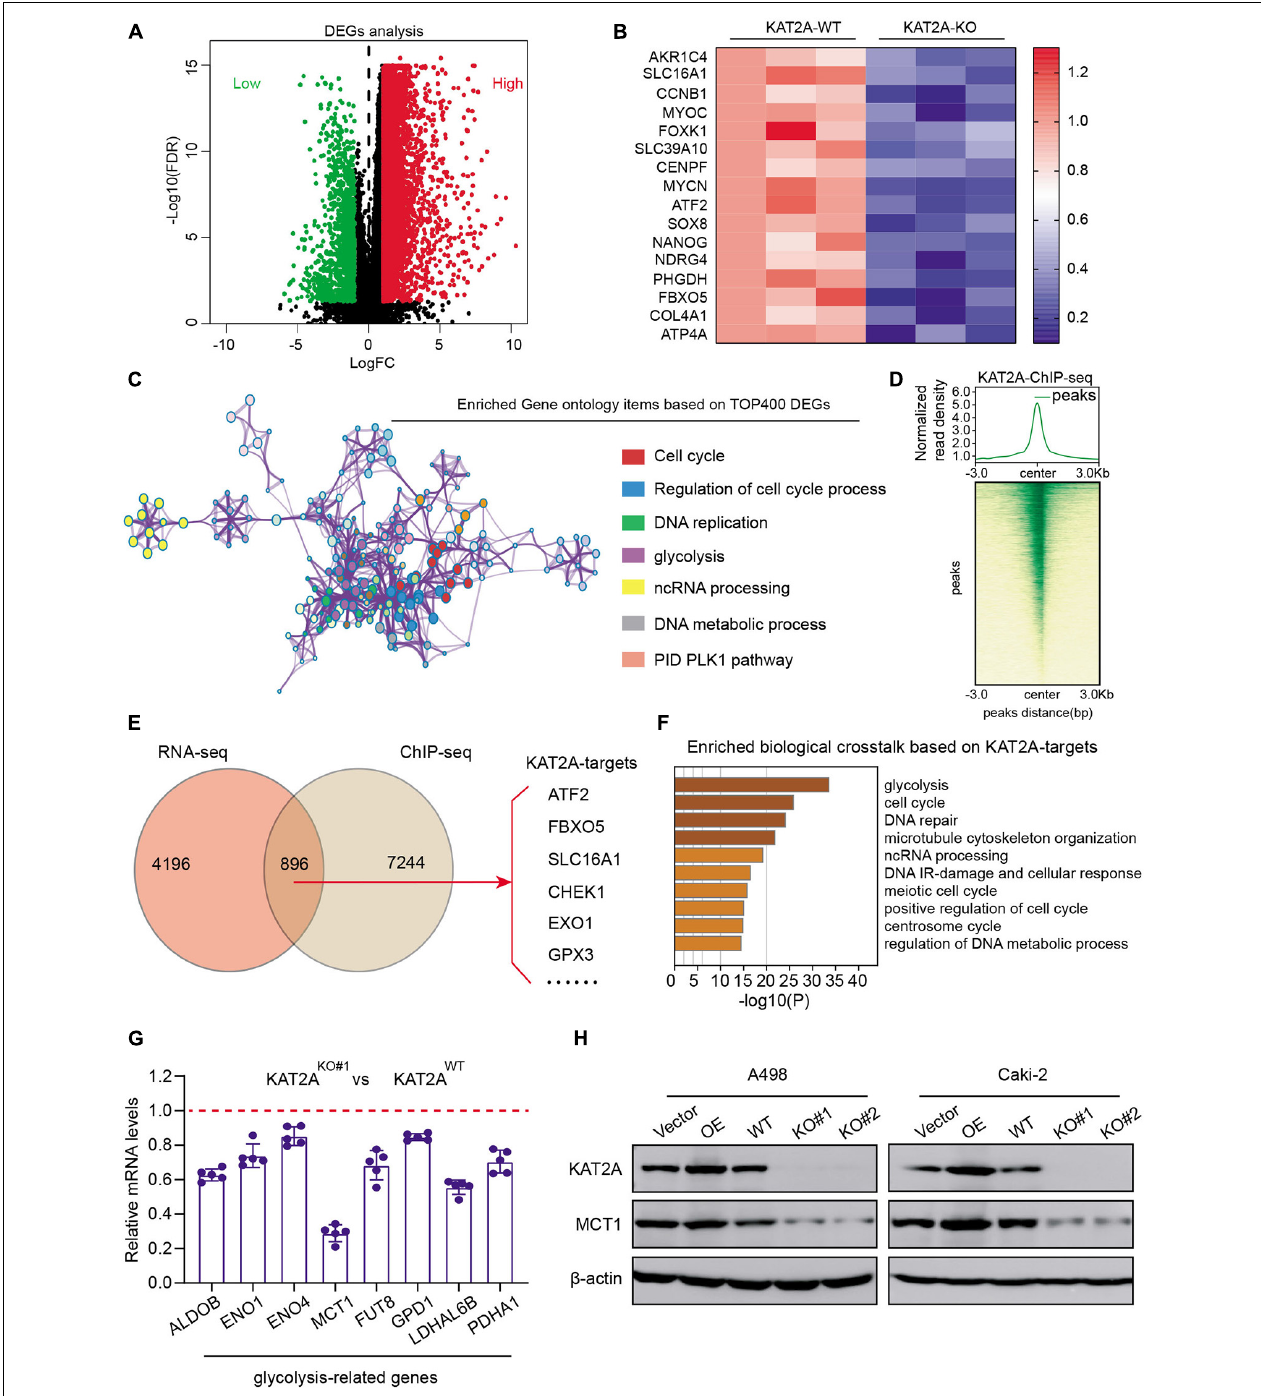
FIGURE 4 | KAT2A alters oncogenic transcriptome and mainly activates downstream MCT1 expression. (A) Volcano plot revealing the differentially expressed genes (DEGs) between KAT2A deficiency and WT control Caki-2 cells. (B) Heatmap summarizing independent RNA-seq expression data of Top DEGs, as indicated. (C) Enriched Gene ontology (GO) items based on TOP400 DEGs were shown, where different colors represented different GO biological processes. (D) ChIP-Seq summary diagram of KAT2A-binding intensities across KAT2A peaks in Caki-2 cells (upper). Heatmap reflecting ChIP-seq signals displayed from − 3 to + 3 kb surrounding the center of each peak (lower). (E) Venn diagram showing the overlapped genes with ChIP-seq data and DEGs. (F) Enriched biological crosstalk based on KAT2A-targets. (G) RT-qPCR analysis of indicated gene expressions in KAT2A-WT and KAT2A-deficient cells. (H) The associations between KAT2A and MCT1 protein levels were further confirmed via Western blotting assay in A498 and Caki-2 cells.